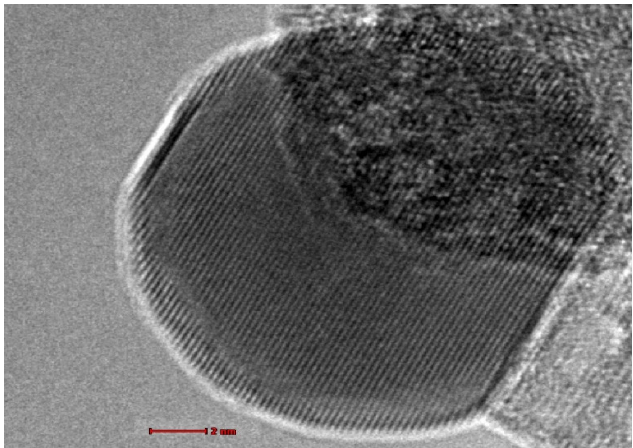
Figure 3. TEM image of nano TiO 2 .